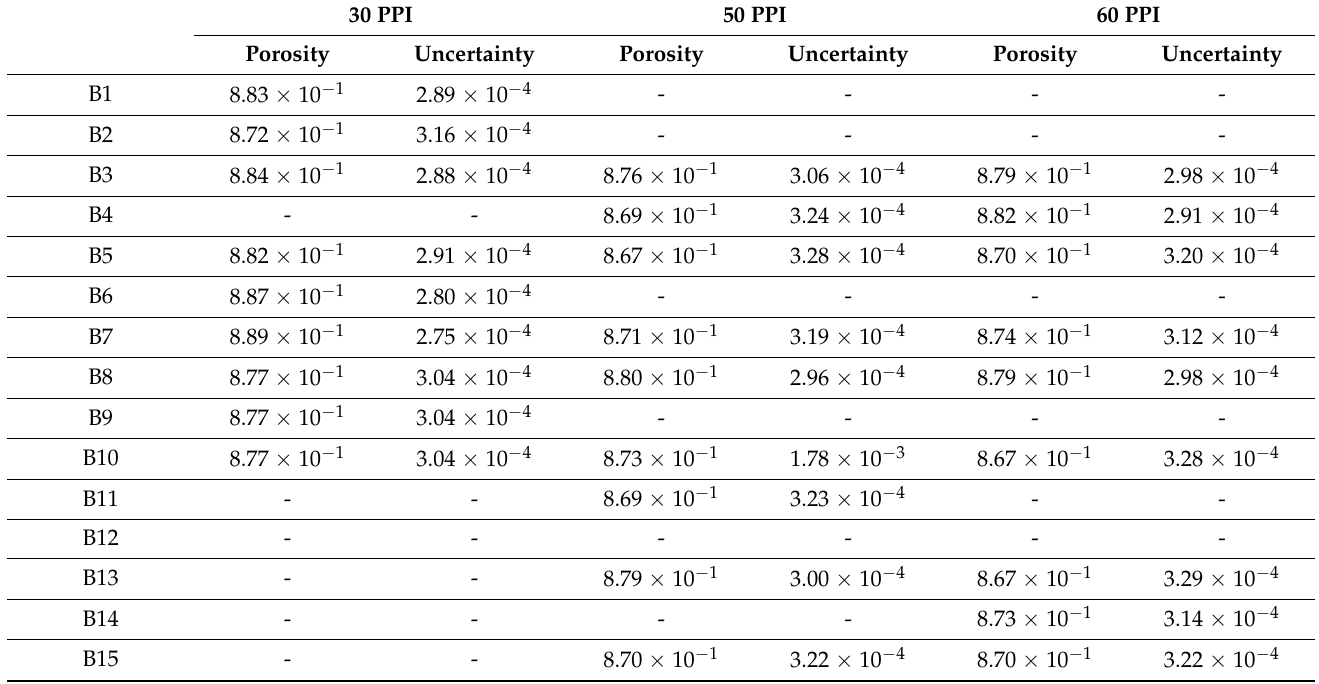
Table A3. The porosity of CFF samples of 30 PPI, 50 PPI and 60 PPI from supplier B. 30 PPI